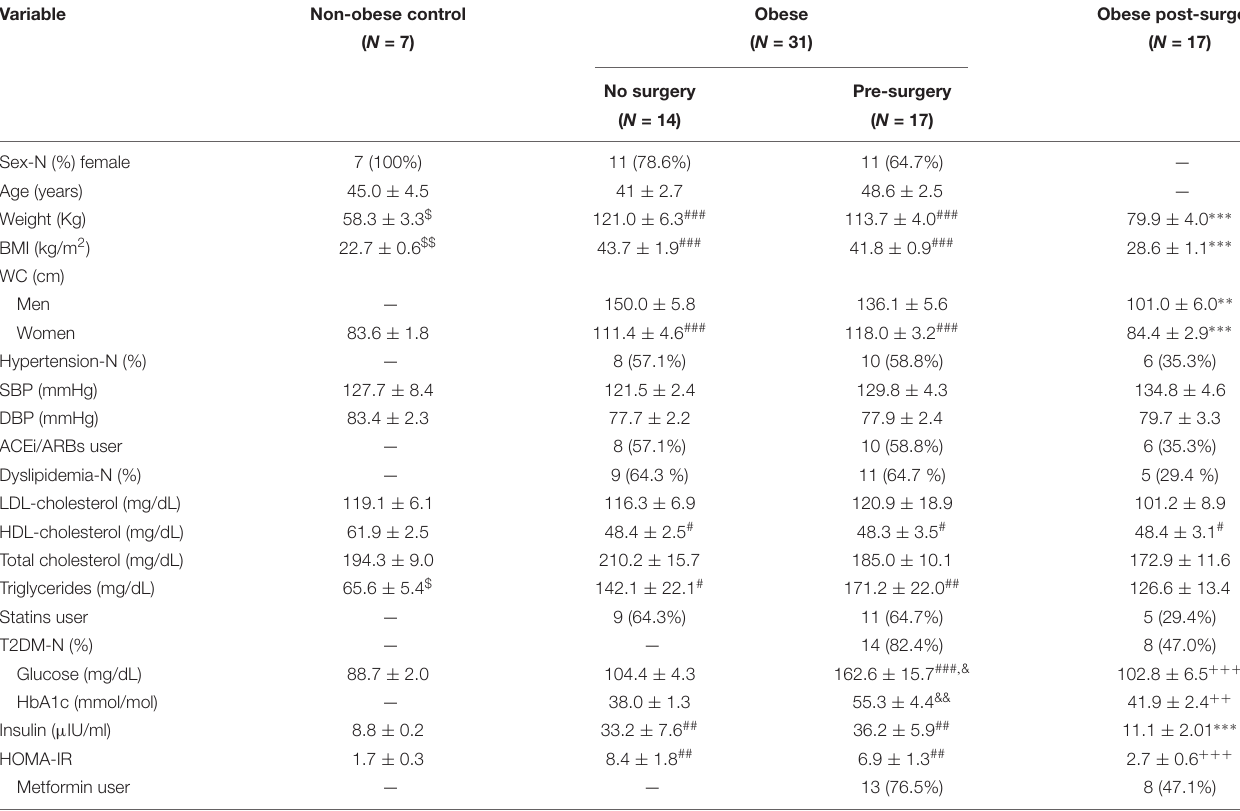
TABLE 1 | Patients’ characteristics.